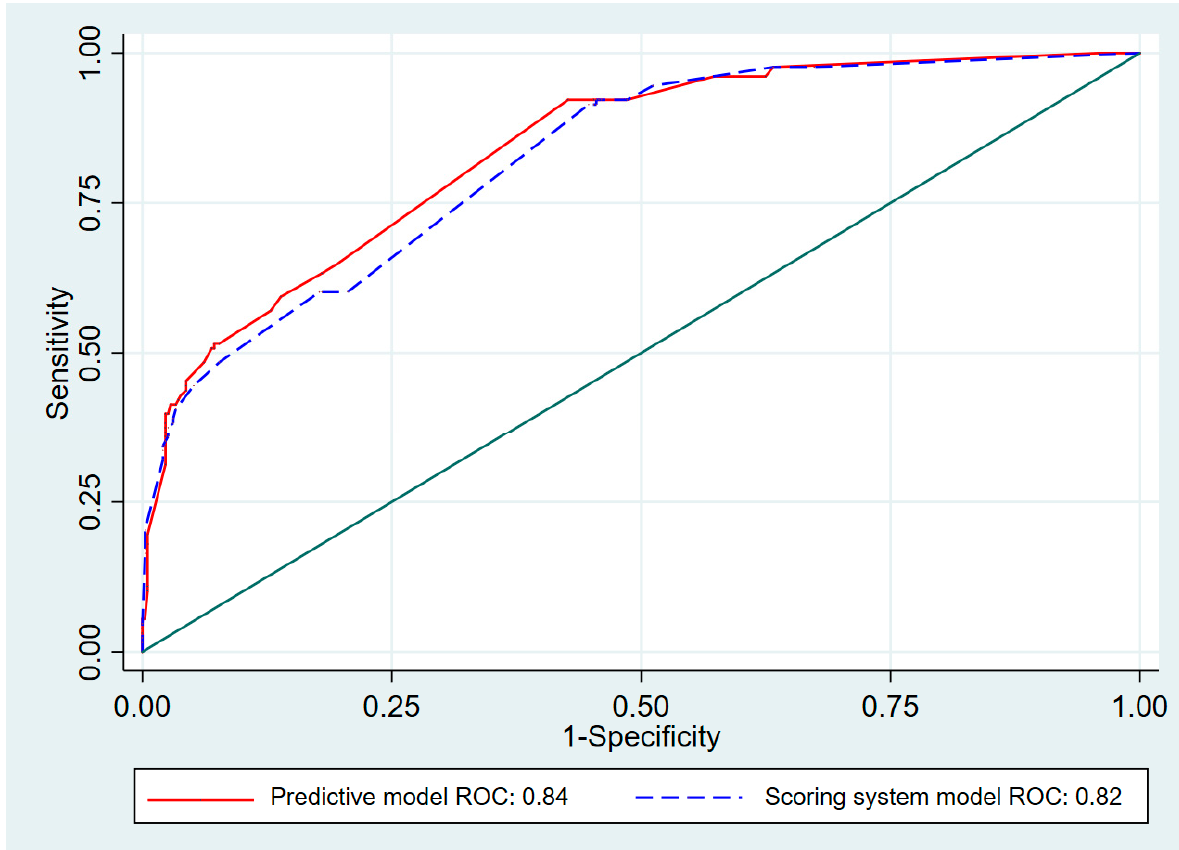
Figure 1. Area under receiver operating characteristic (AuROC) curve of adrenal insufficiency predicted by risk scoring system and predictive model (curved line) and 50% chance prediction (diagonal line).